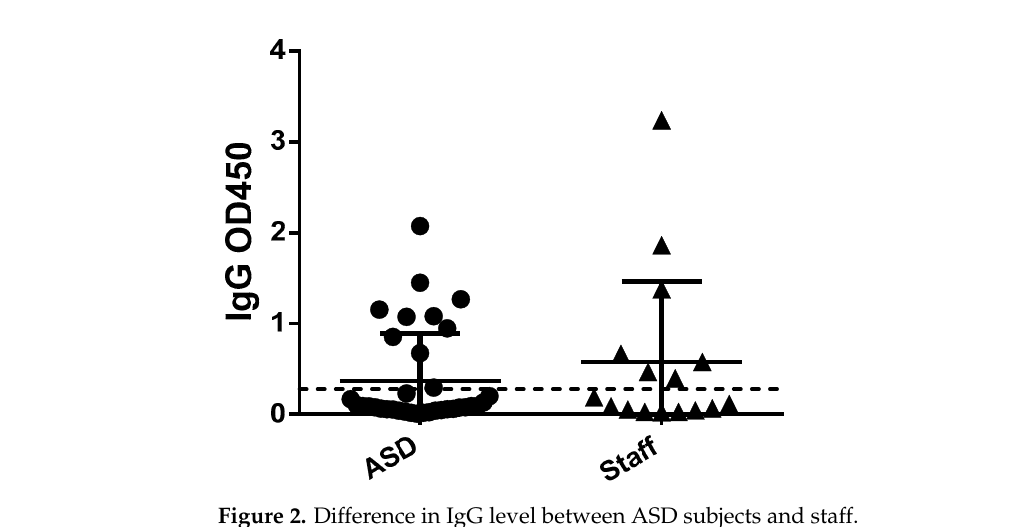
Figure 2. Difference in IgG level between ASD subjects and staff.